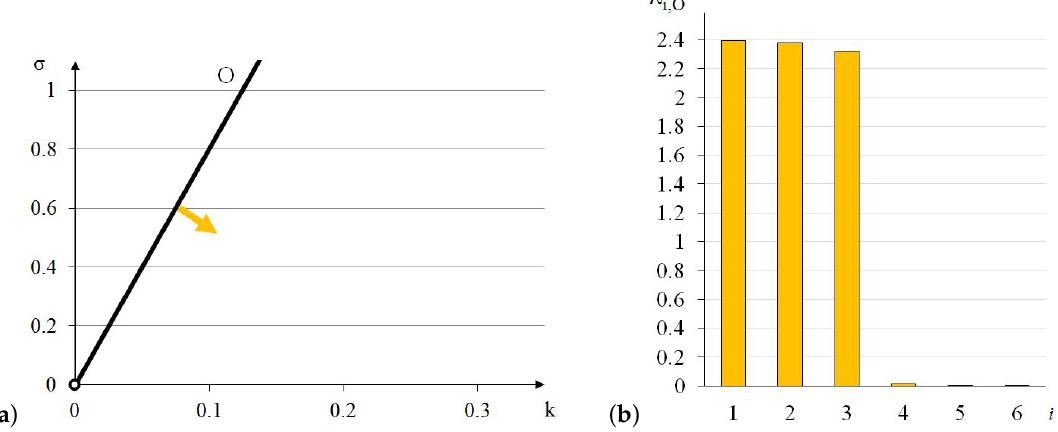
Figure 11. Extreme properties of the expanded octahedron: ( a ) Line of extreme properties σ = 8.03 · k . ( b ) Distribution of eigenvalues for k = 0.1, σ = 0.803 (multiplier EA / a 2 ).